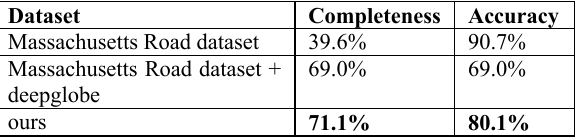
Table 2. Results of different datasets